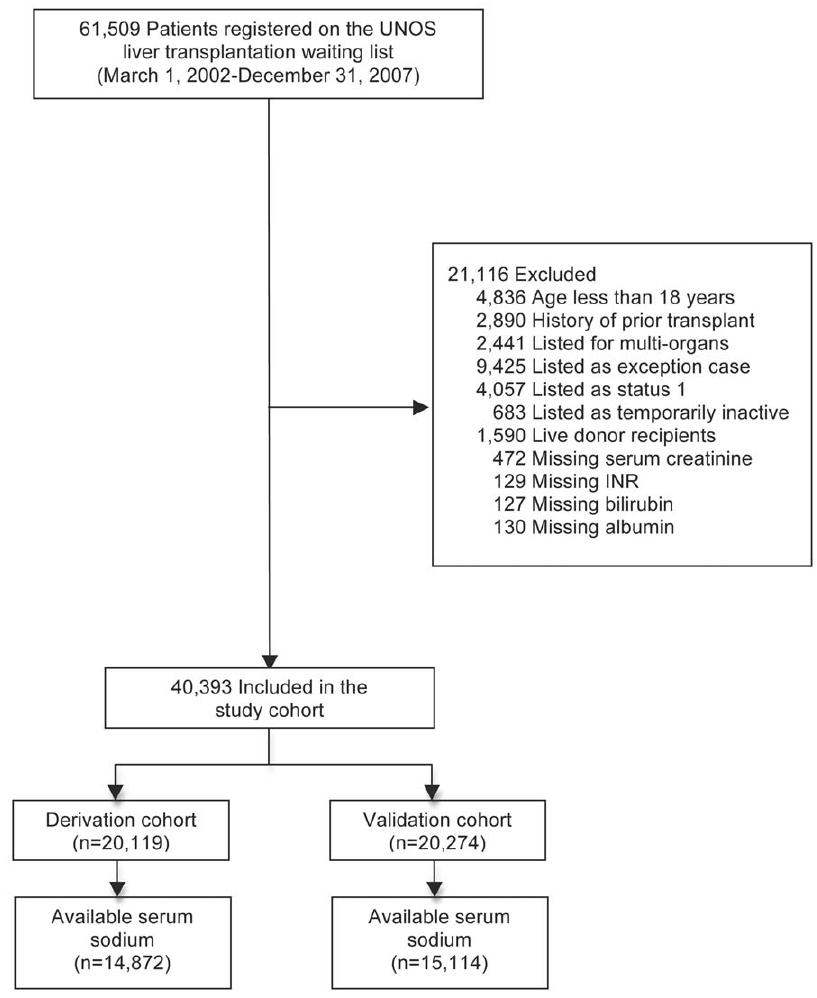
Figure 1. Flow diagram of patients registered on the UNOS liver transplant waiting list in the United States between March 1, 2002 and December 31, 2007. Only patients with available serum sodium concentrations were included in statistical comparisons between models.